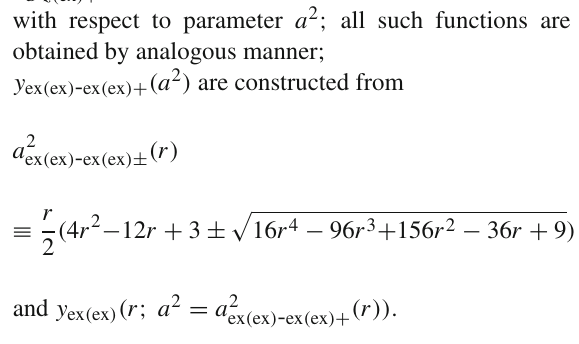
Fig. 7 The functions y max ( h ) ( a 2 ) (bold full curve), y min ( h ) ( a 2 ) (bold dashed curve), y d - z ( ex ) + ( a 2 ) (bold dash-dotted curve), y max ( d ) ( a 2 ) (full curve), y max ( d ( ex )) ( a 2 ) (dashed curve), y ex ( ex ) - ex ( ex ) + ( a 2 ) (dash-dotted) and y = 1 / a 2